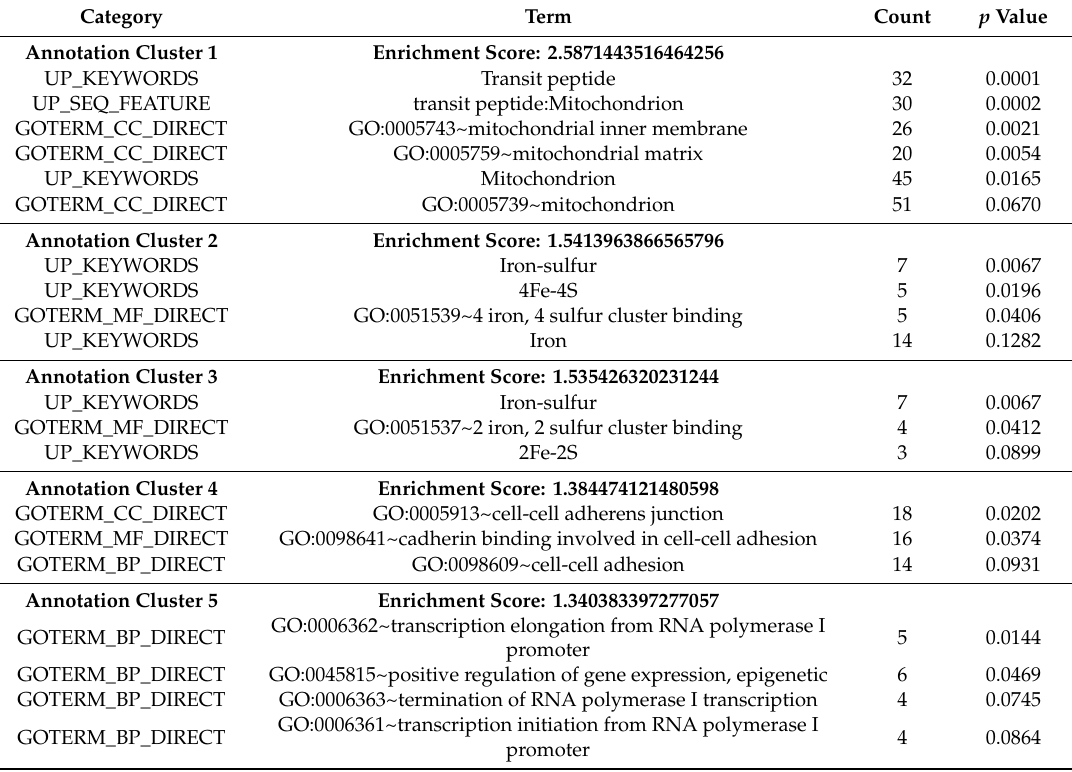
Table 2. Functional annotation of genes expressed uniquely in specimens from male patients with Cushing’s disease.